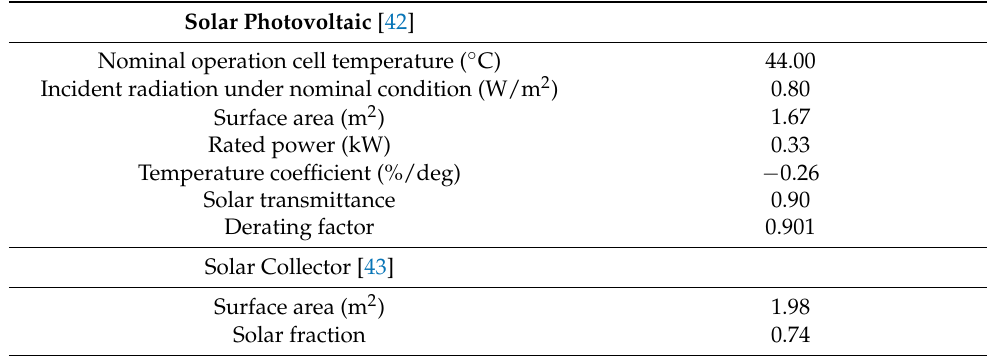
Table 4. Technical specification of the photovoltaic and solar collector used in this research.